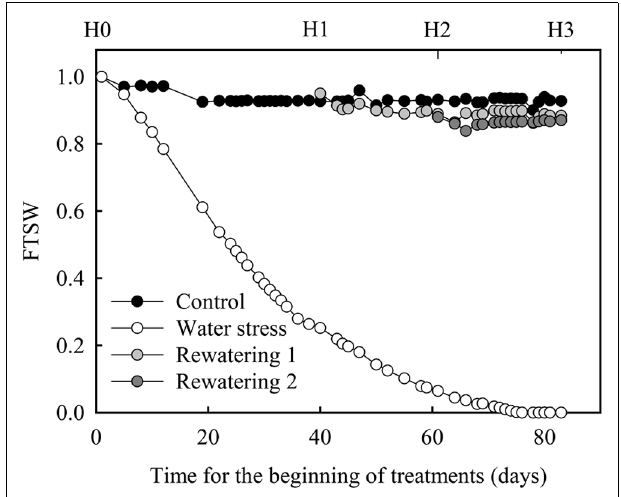
FIGURE 1 | FTSW evolution during the greenhouse experiment on oil palm. FTSW is defined as the ratio of actual plant-available soil water (ASW) content to the total plant-available soil water (TTSW). H0, H1, H2, and H3 refer to the four harvest dates. H0 (start of the dry-down), H1 (relative transpiration of water stressed plants = 0.2 and rewatering of the plants of the rewatering 1 treatment), H2 (3 weeks after H1 and rewatering of the plants of the rewatering 2 treatment), and H3 (3 weeks after